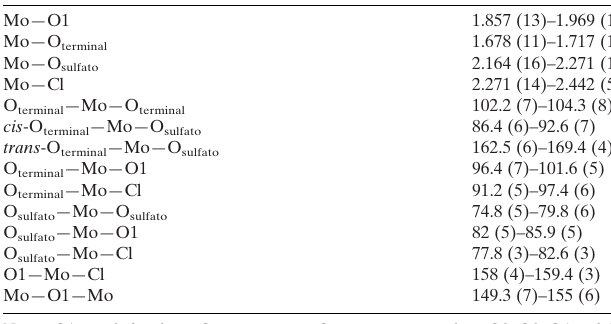
Geometrical parameters (A˚ , (cid:3) ) for the three crystallographically inde- pendent molybdenum